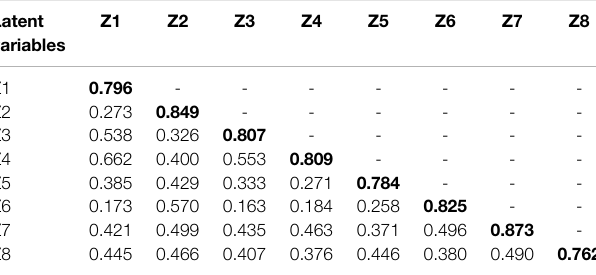
TABLE 4 | Correlation coef fi cient between latent